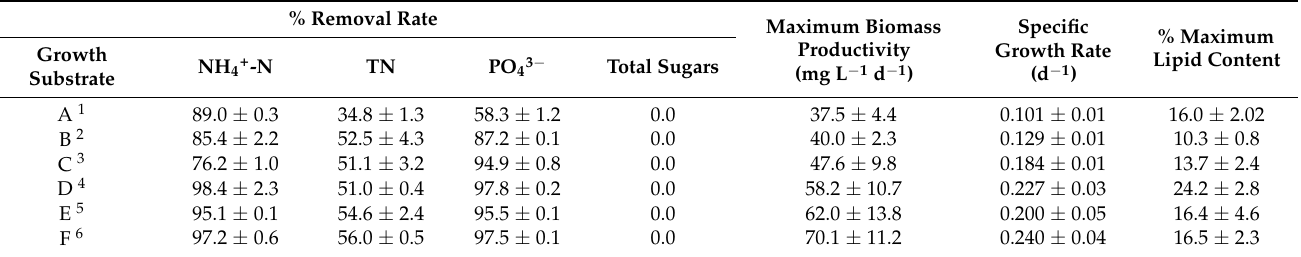
Table 3. Ammonium nitrogen removal rates, biomass productivities, specific growth rates and lipid contents achieved under the different fertilizer quantities.